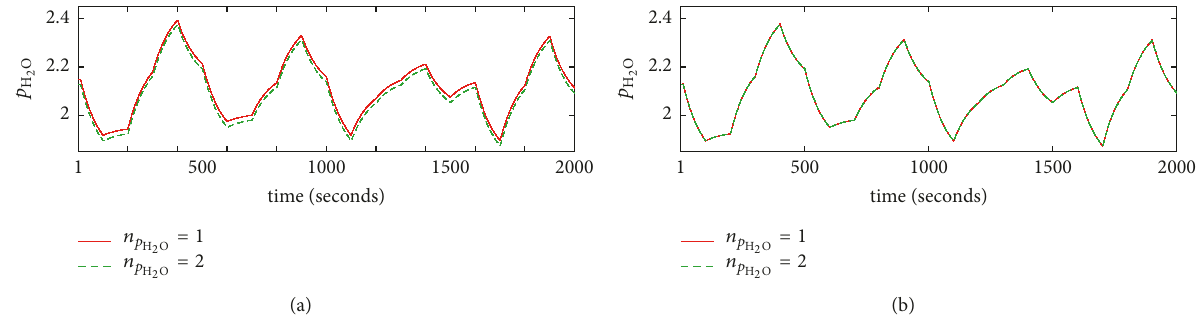
= 1 ) and full order ( 𝑛 = 2 ) models determined by algorithm 𝑝 H 2 O H 2 O